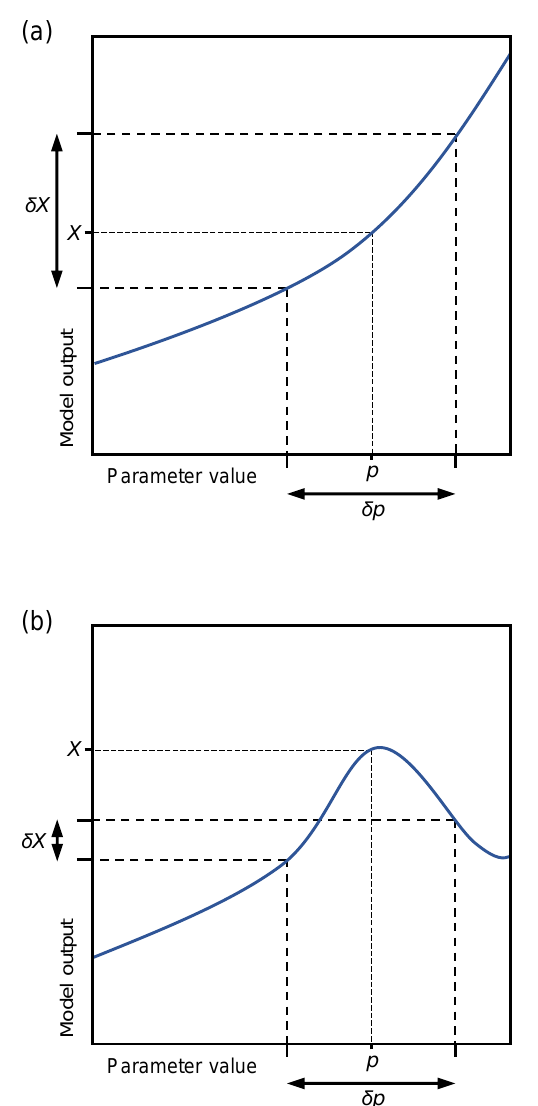
Figure 6. Simulated response of autotrophic ( A 1 − 3 ) biomass (blue line) and heterotrophic ( H 1 − 3 ) biomass (red line) to variation in (a) Q 10 and (b) I max H across the entire range of plausible val- ues, forced with meteorological data from the Damma Glacier over 75 years. The shaded segment shows the region in which model sensitivity ( λ) is